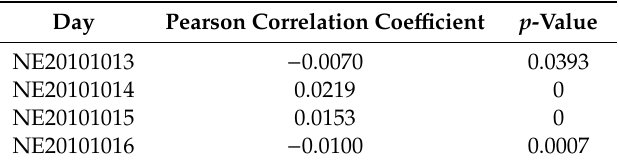
Table 6. Temporal correlation analysis for